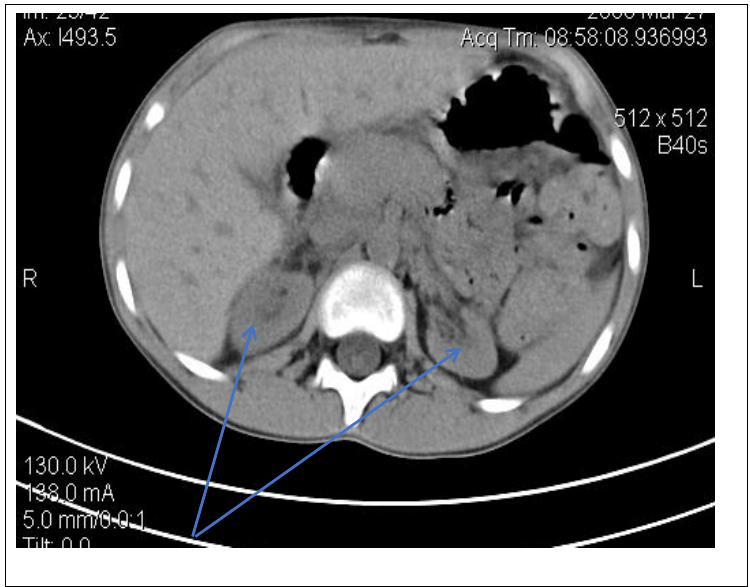
Figure 13. Abdominal CT scan—disappearance of renal hyperechoic formations (blue arrow). In evolution, the patient benefited from a kidney transplant after 2 years of renal substitution therapy.